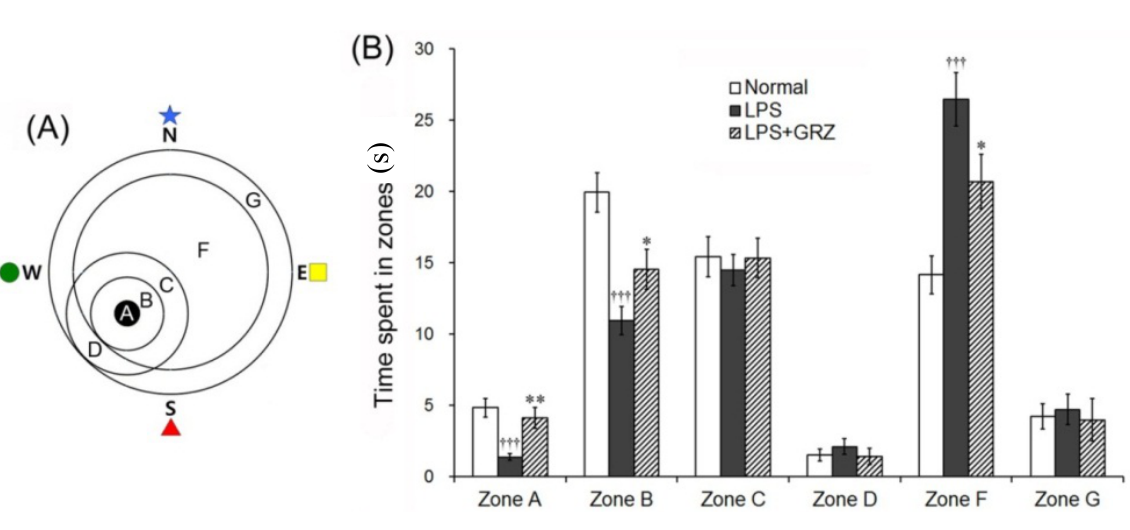
Figure 6. Effects of GRZ on the swimming time spent in discrete zones. Computerized grid design used in the retention test. Discrete zones are labeled with letters, zone A representing the platform site ( A ) GRZ significantly prolonged the swimming time spent in zones A and B, while significantly shortened in zone F; and ( B ) Data are represented by mean ± SEM (n = 12 in each group; ††† p < 0.001 compared to the normal group; * p < 0.05; ** p < 0.01 compared to the LPS